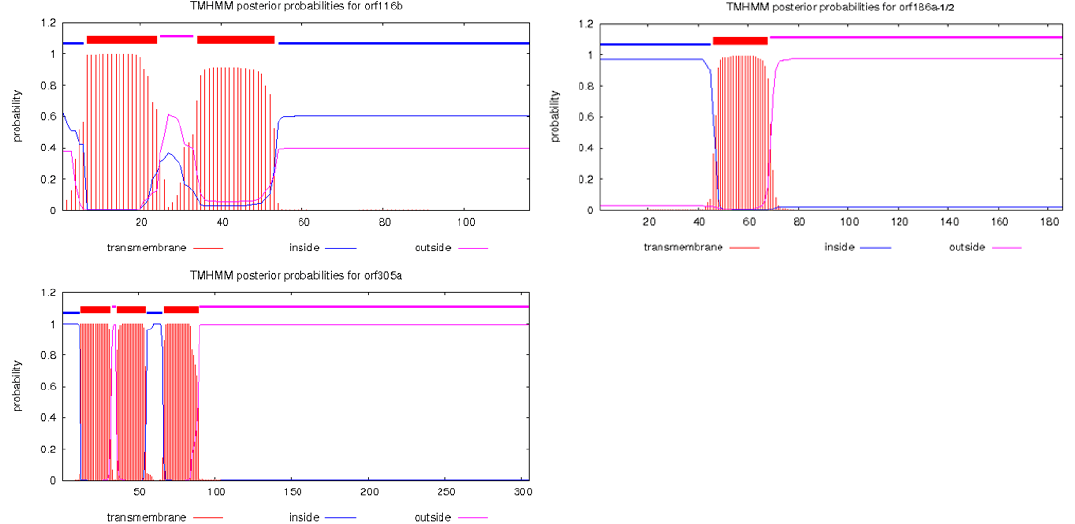
Figure 4. The probability of transmembrane domains of orf116b , orf186a-1 / -2 (the sequences of orf186a-1 and orf186a-2 were the same and had the same transmembrane domain) and orf305a.